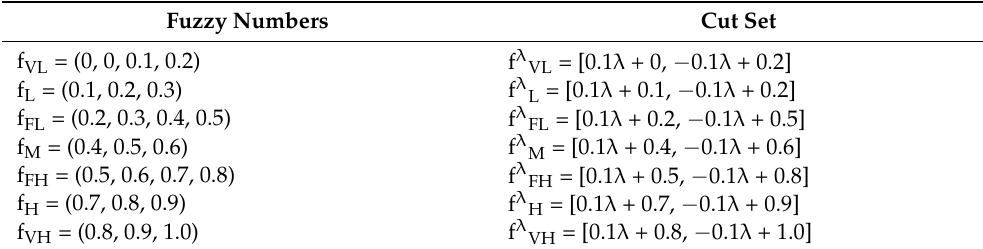
Table 1. Event probability fuzzy numbers and Cut